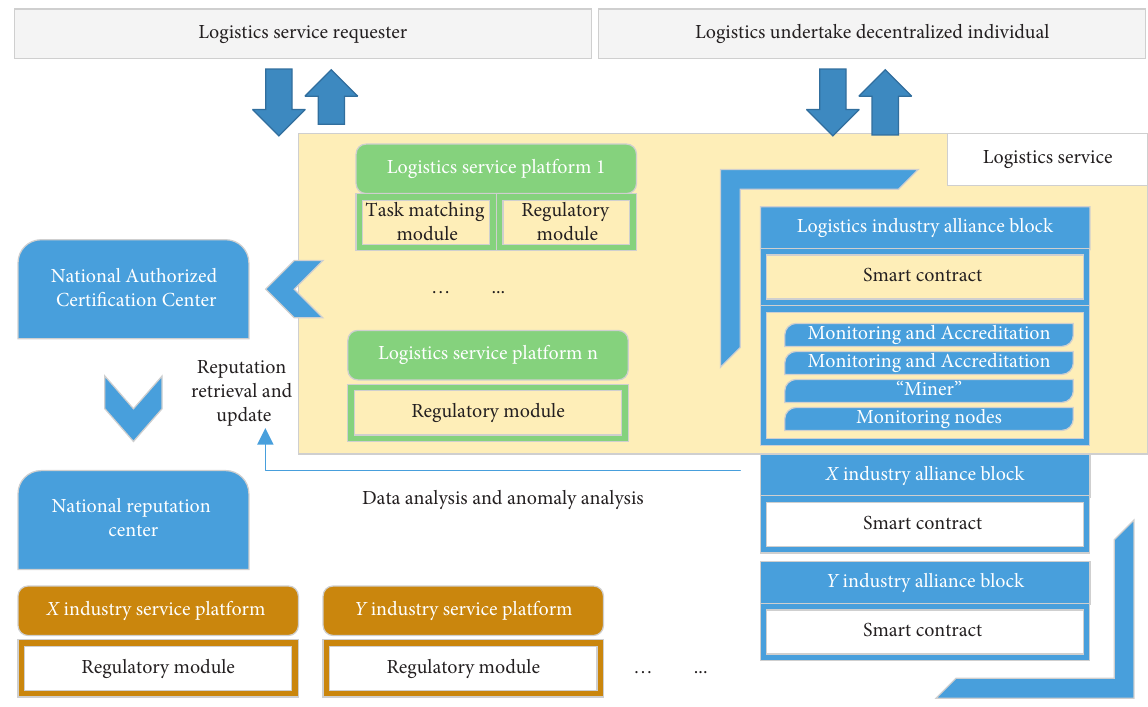
Figure 4: Electronic commerce logistics supervision